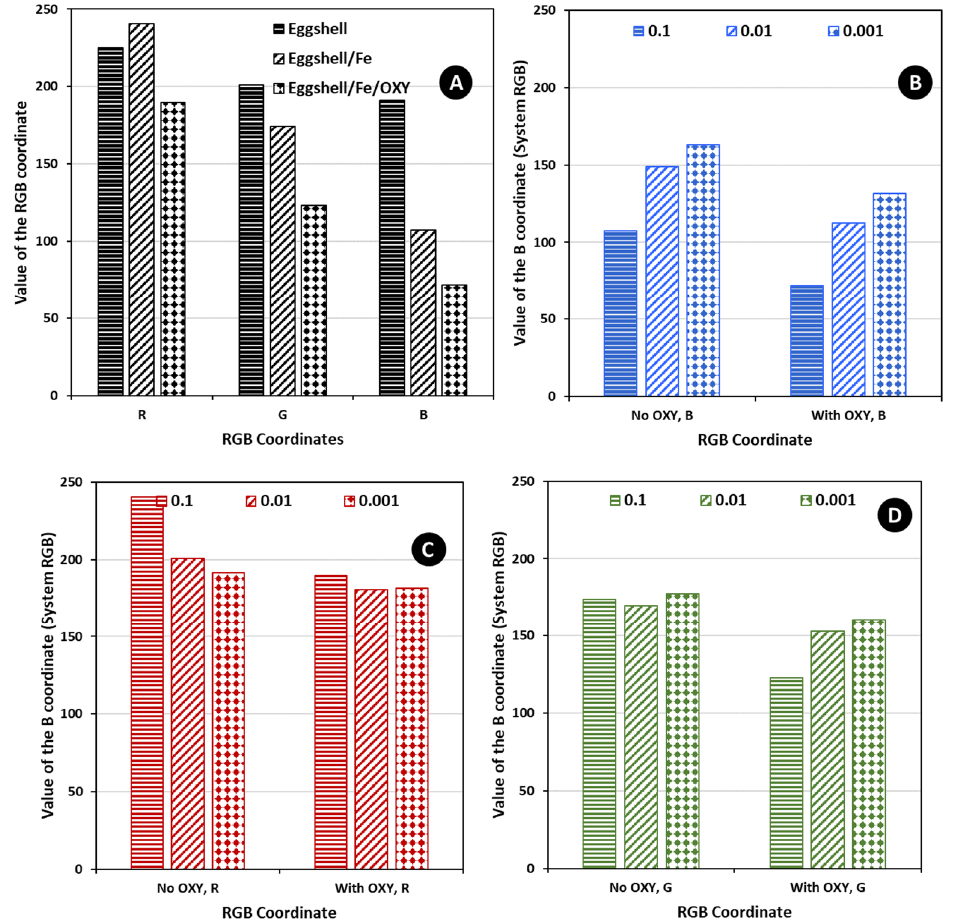
Figure 4. Average values of the RGB coordinates for at least 3 random measures in Paint, ( A ) for the various stages of material modification, setting the concentration of iron to 1.0 × 10 −1 mol/L, and ( B – D ) for a given coordinate value obtained with the several concentrations of iron tested.